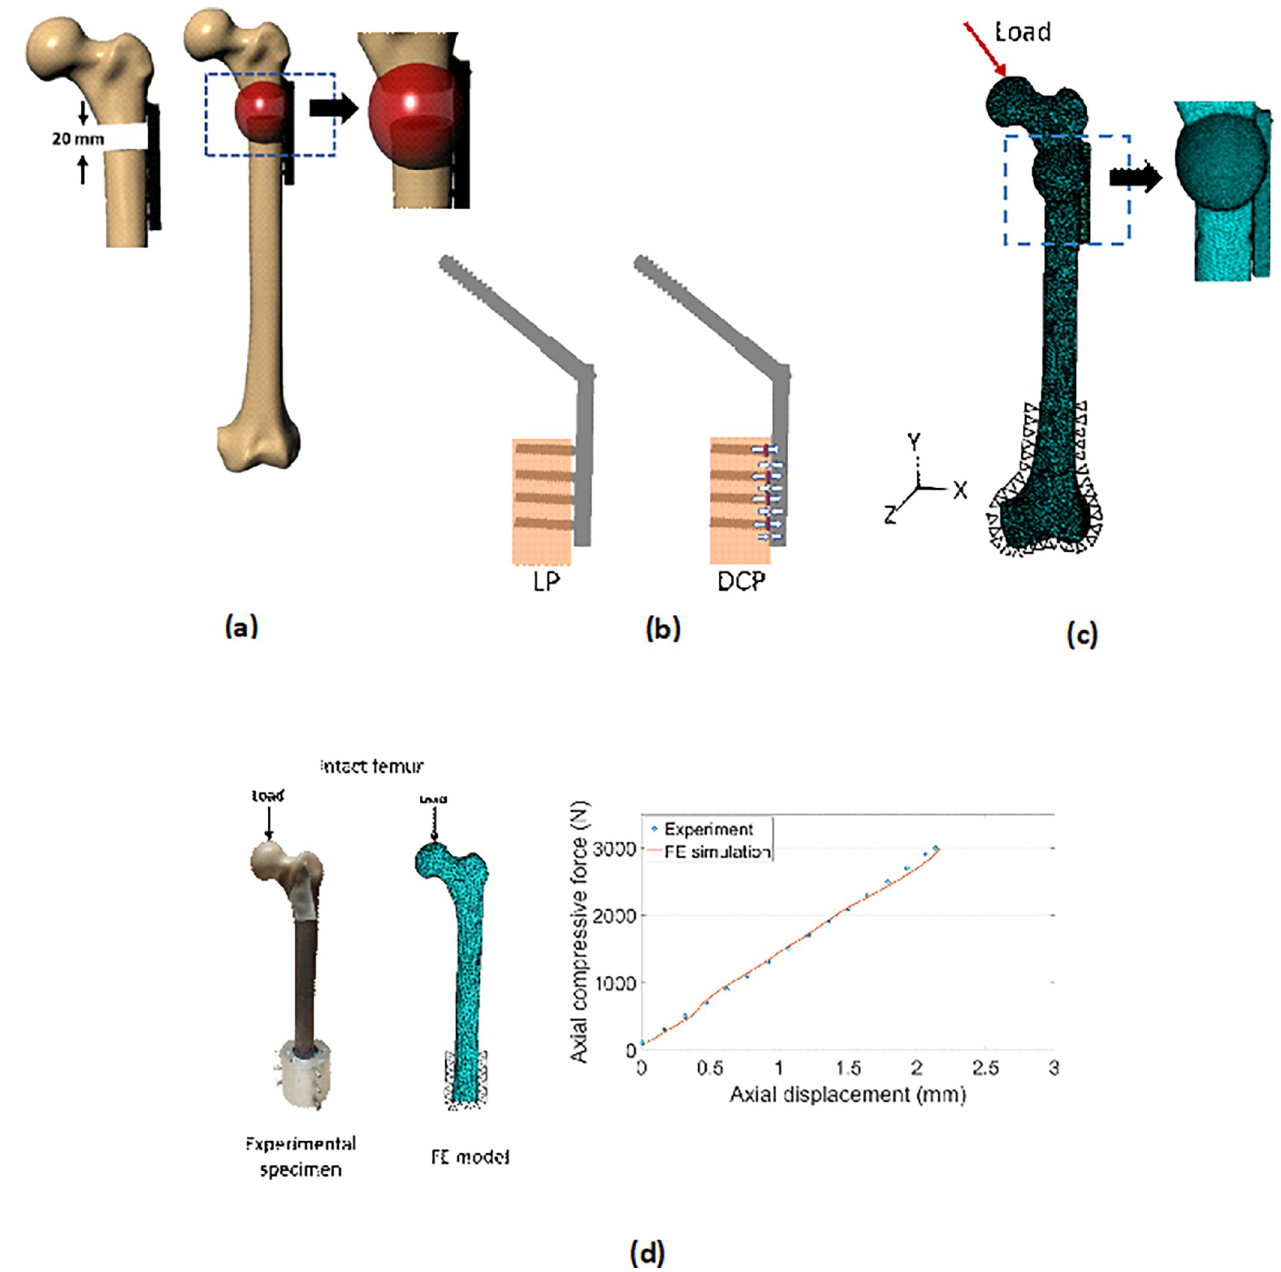
Fig 2. Virtual models of the bone constructs and experimental validation: (a) CAD model of femur having fracture gap of 20 mm along with formed callus, (b) CAD models of LP and DCP with depiction of preloads—the red regions indicating preload and white arrows specifying the direction of the preloads and (c) 3D FE model of implanted femur under compressive loading and (d) experimental validation of the intact femur under static compression loading. standard error of estimate (SE = 0.02 mm) along with a regression slope, b~1.0 (PE of b = 1.4%), and intercept of a = 0.022 were predicted for the intact femur (95% confidence interval). This imparted confidence in the efficacy of the FE model generation scheme which was further employed to develop the plated constructs (LP and DCP).